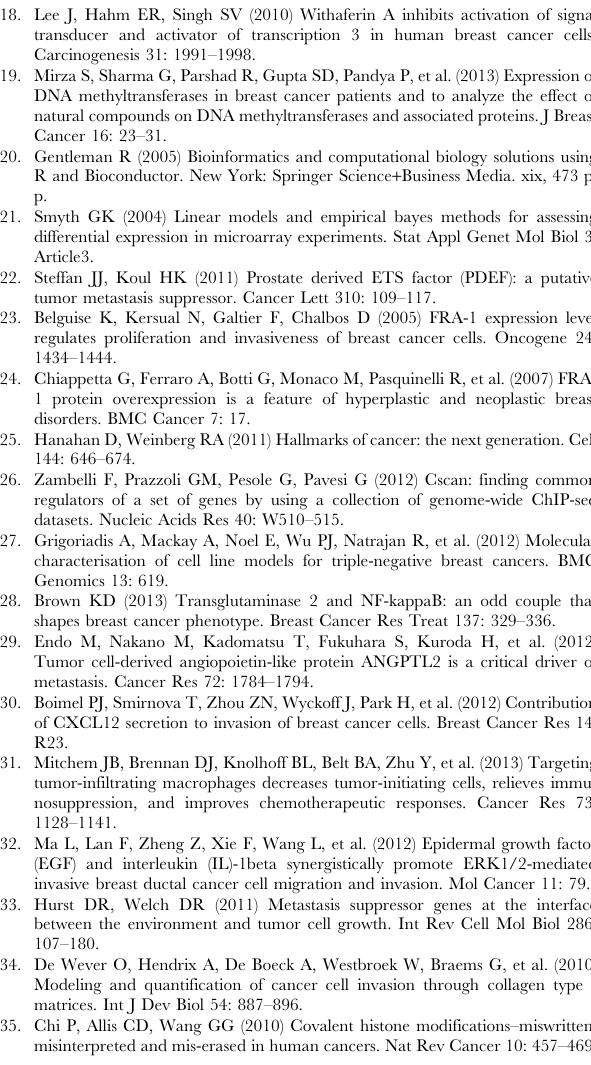
Table S2 A list of experimentally validated ChIP- sequencing data for genes regulated by H3K4me2,me3 in Human Mammary Epithelial Cells